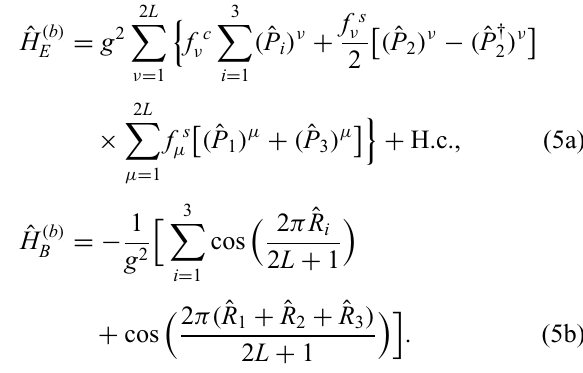
FIG. 3. The single periodic boundary plaquette for a pure gauge theory. (a) The representation in terms of the eight gauge fields (blue arrows) that are associated with the links of the lattice. (b) The representation in terms of independent gauge- invariant (i.e., physical) operators called “rotators.” As explained in Ref. [28], the plaquette can be seen as an infinite lattice of pla- quettes. Moreover, to explore the ground-state properties, only three independent rotators, ˆ R 1 , ˆ R 2 , and ˆ R 3 (shown in solid blue), are sufficient for describing the